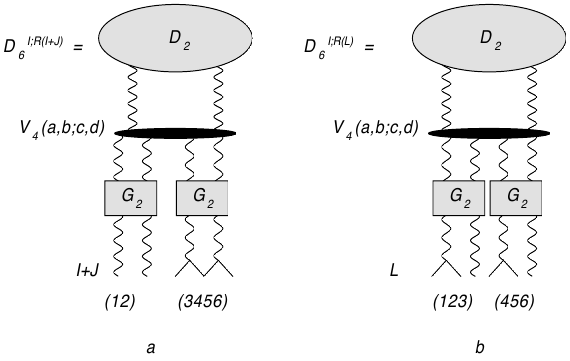
: (a) D I ; R ( I + J ) , (b) D I ; R ( L ) . As in 6 6 6